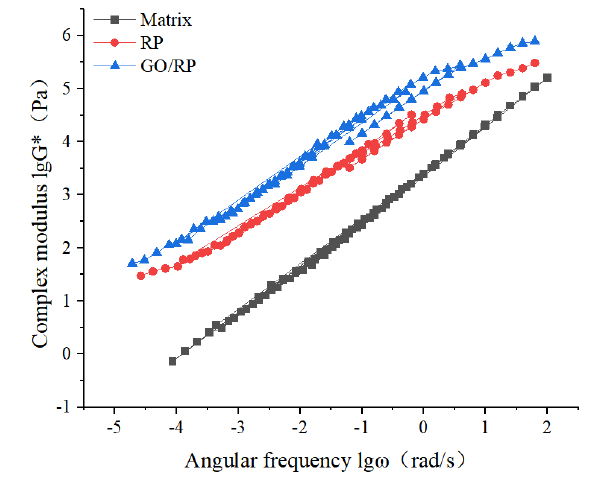
Figure 5. The main curves of complex modulus of three kinds of asphalt at 40 °C.